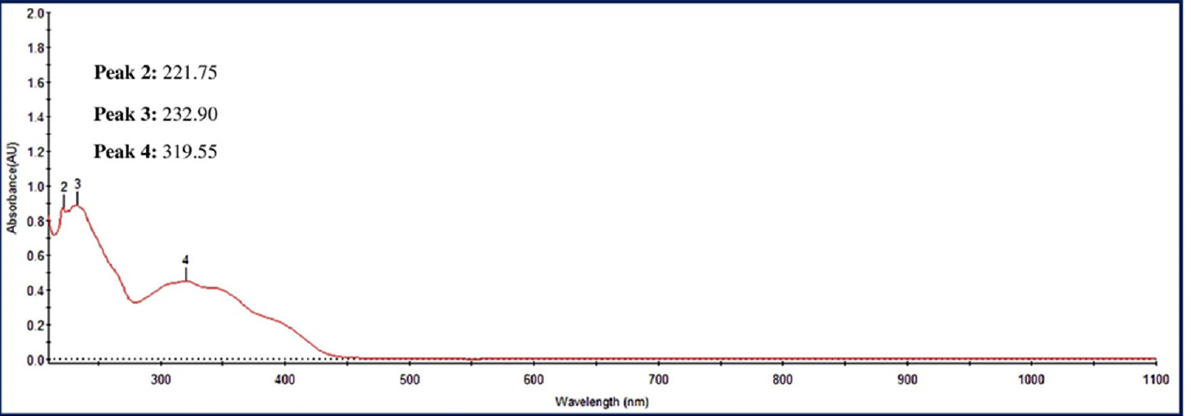
Figure 3. UV-visible spectrum analysis of MA-CNPs.